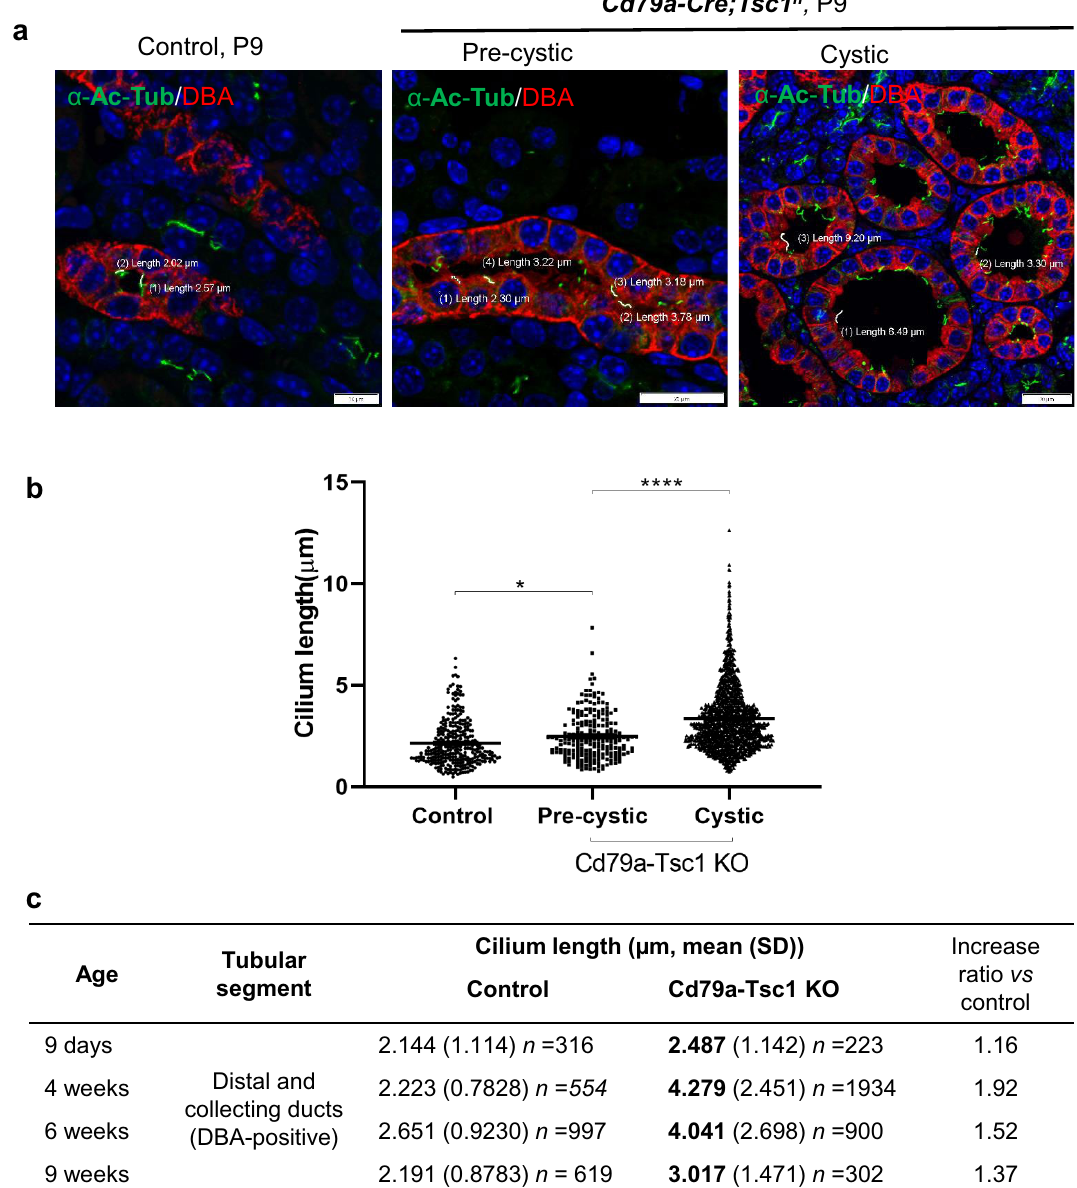
Figure 8. Morphologic changes of primary cilia during cyst progression. ( a ) Kidney sections of Cd79a-Tsc1 KO mice and controls at postnatal day (P) 9 are costained with anti-acetylated α-tubulin antibodies (α-Ac-Tub, green) and DBA (red), markers for cilia and the distal tubule/collecting duct, respectively. Cilia length in DBA- positive cells is measured for both pre-cystic (normally shaped tubules) and cystic lesions (area > 2000 µm 2 ). ( b ) The aggregate quantification of cilia length in P9 and P11 tubular cells. The average length of pre-cystic, as well as cystic lesions, is compared between control and Cd79a-Tsc1 KO tubules. ( c ) Changes in cilia length over time during cyst expansion in Cd79a-KO tubules. The average cilia length was calculated from the total cilia number (n) including both normally shaped pre-cystic and cystic lesions. Cillia in Cd79a-KO tubules became longer in proportion to cyst expansion and reached a maximum length at 4 weeks of age. These data were obtained from at least 3 litters for different age. Data represent mean ± SEM and were statistically assessed by one-way ANOVA. * P < 0.05 and **** P <